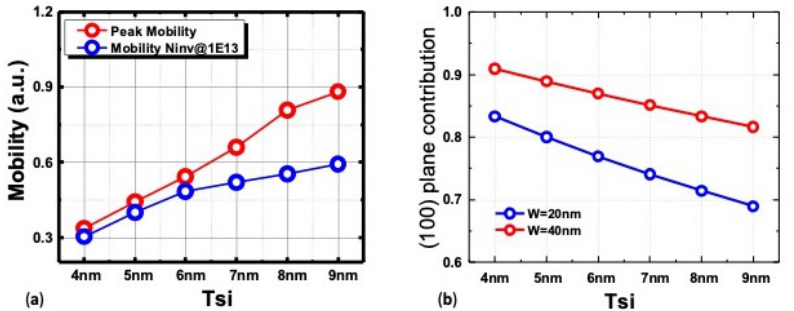
Figure 6. ( a ) This plot shows the extracted peak hole mobility and hole mobility for N inv @10 13 /cm 2 as a function of silicon channel thickness. Degradation in hole mobility is evident for thin sheet values; ( b ) calculated <100> plane contribution to total W ef f as a function of T Si (a pure geometrical percentage of the whole nanosheet perimeter)